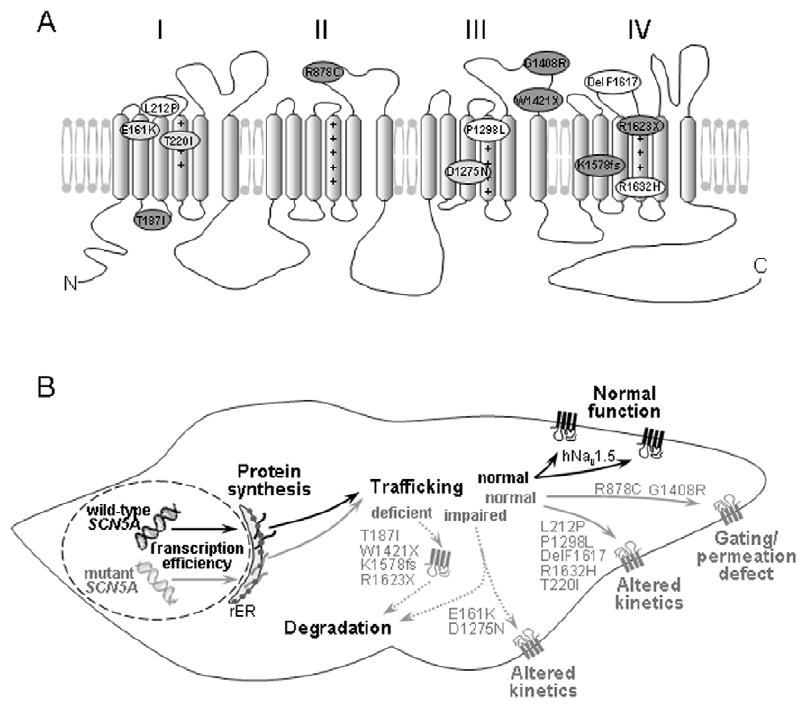
Figure 7. Summary of the molecular mechanisms underlying SCN5A -related familial SSS. (A) Proposed membrane topology of hNa v 1.5 showing the locations of the thirteen SSS-associated mutations investigated here. Compared to wild-type hNa v 1.5, the mutant channels produced either similar (group 1, white), reduced (group 2, light grey) or no (group 3, dark grey) current. (B) Schematic representation of a sinus node cell and the cellular mechanisms involved in SCN5A -related familial SSS. Early onset of familial SSS occurred (a) when two alleles were affected (compound mutations P1298L/G1408R, DelF1617/R1632H, and T220I/R1623X) [16], or (b) when other risk factors were present (for example, a Cx40 polymorphism combined with L212P; Table 3) [34]. Notably, when wild-type hNa v 1.5 channels are expressed from the normal allele, most of the mutants also caused other cardiac disorders like BrS, AV block, CCD or DCM, as observed for carriers of T187I, W1421X, K1578fs/52, and E161K (see Discussion and Table 3). In most if not all of these cases, SSS onset relatively